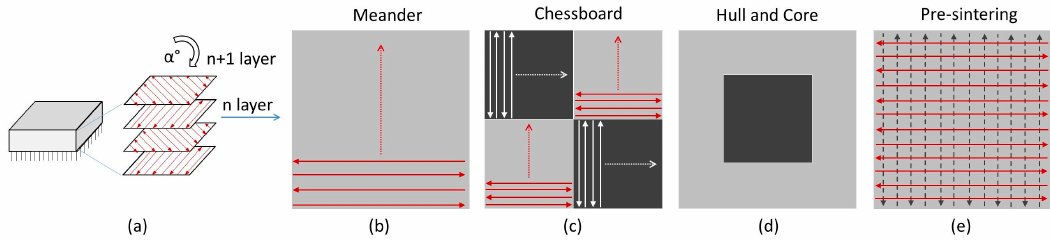
Figure 2. Graphical representation of used strategies; ( a ) layer-based approach, with rotation of scan pattern in follow up layers; ( b ) Meander strategy; ( c ) Chessboard strategy; ( d ) Hull and core strategy; ( e ) Pre sintering strategy.